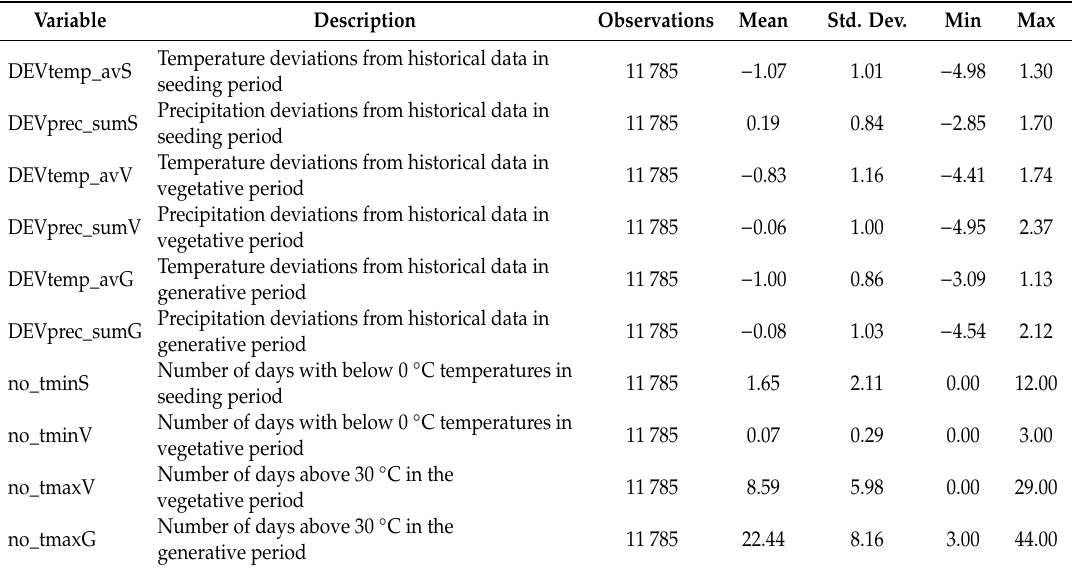
Table 1. Descriptive statistics of variables for